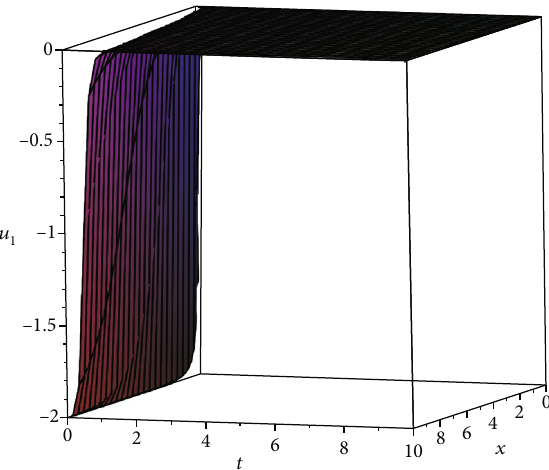
ð t , x Þ of Equation (22) for di ff erential 1